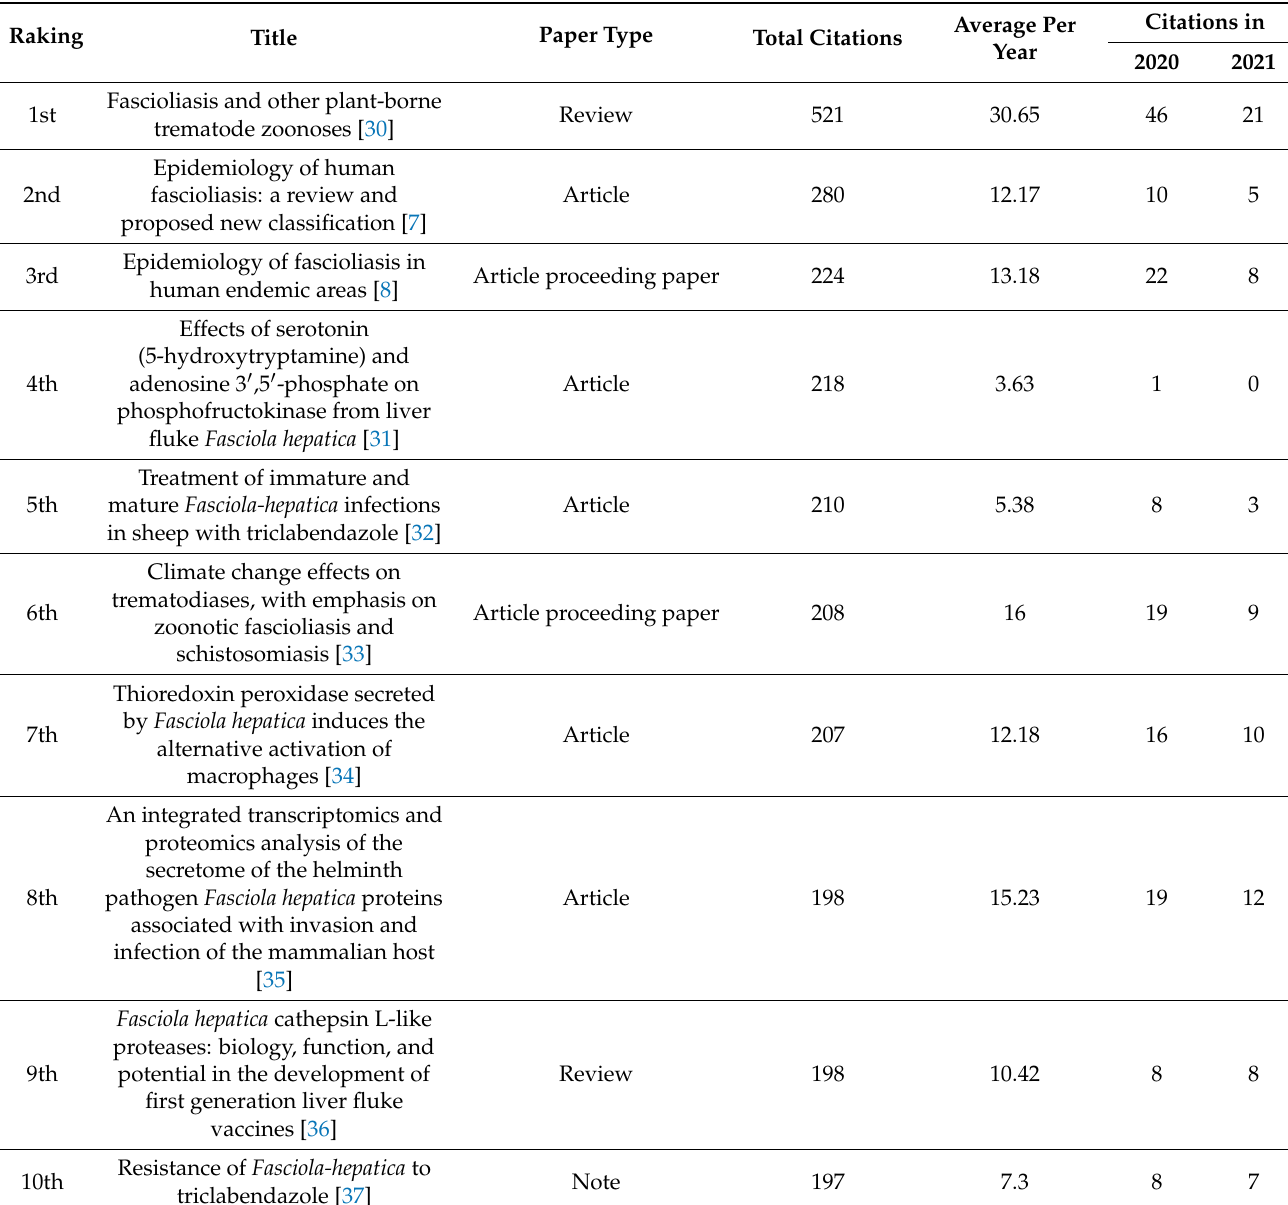
Table 1. Top ten most-cited papers in fascioliasis